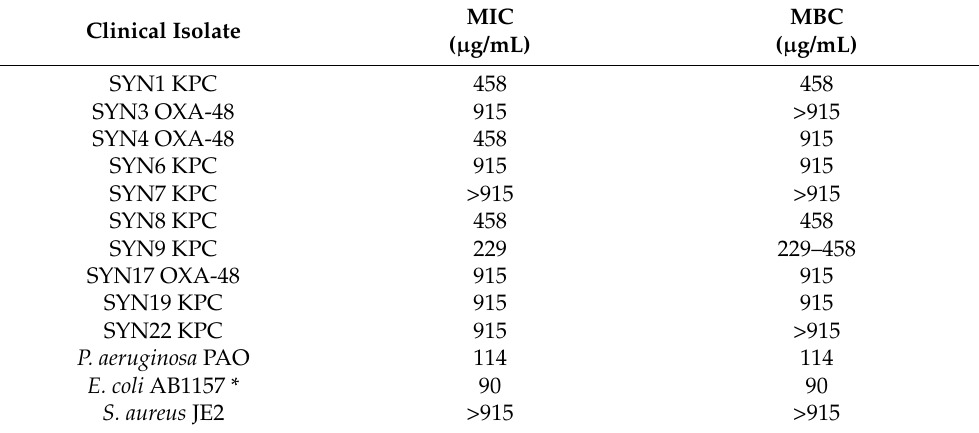
Table 1. Antimicrobial activity of linear oligoethyleneimine hydrochloride (L-OEI-h) against Klebsiella pneumoniae isolates, control bacterial strains ( P. aeruginosa PAO, E. coli AB1157) and the methicillin- resistant Staphylococcus strain S. aureus JE2. Clinical